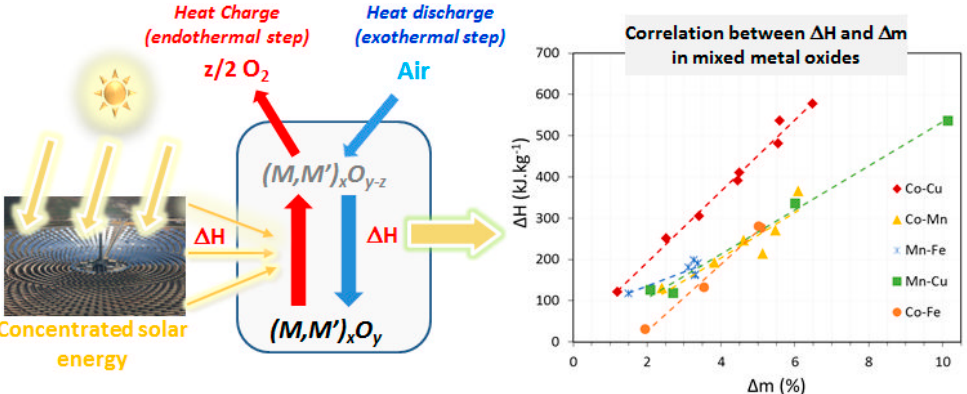
Figure 5. Principle of open loop operation with metal oxides and correlation between enthalpy and oxygen mass exchange in mixed metal oxides.